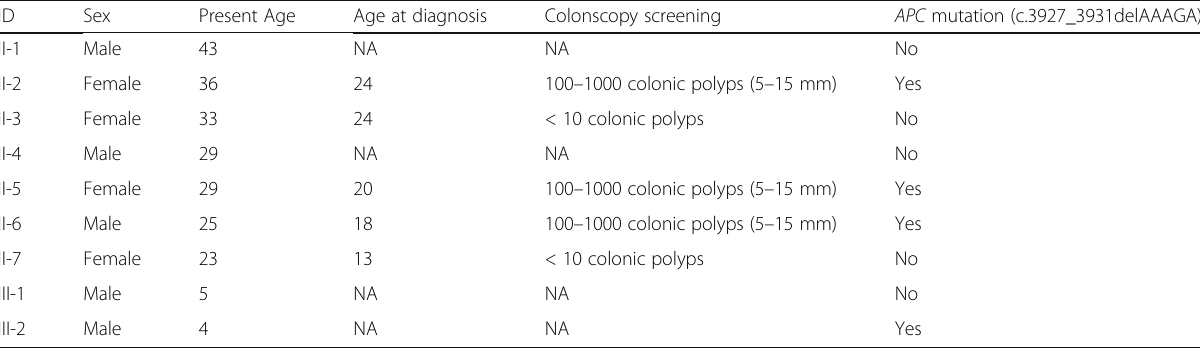
Table 1 Clinical and genetic characteristics of the affected and unaffected family